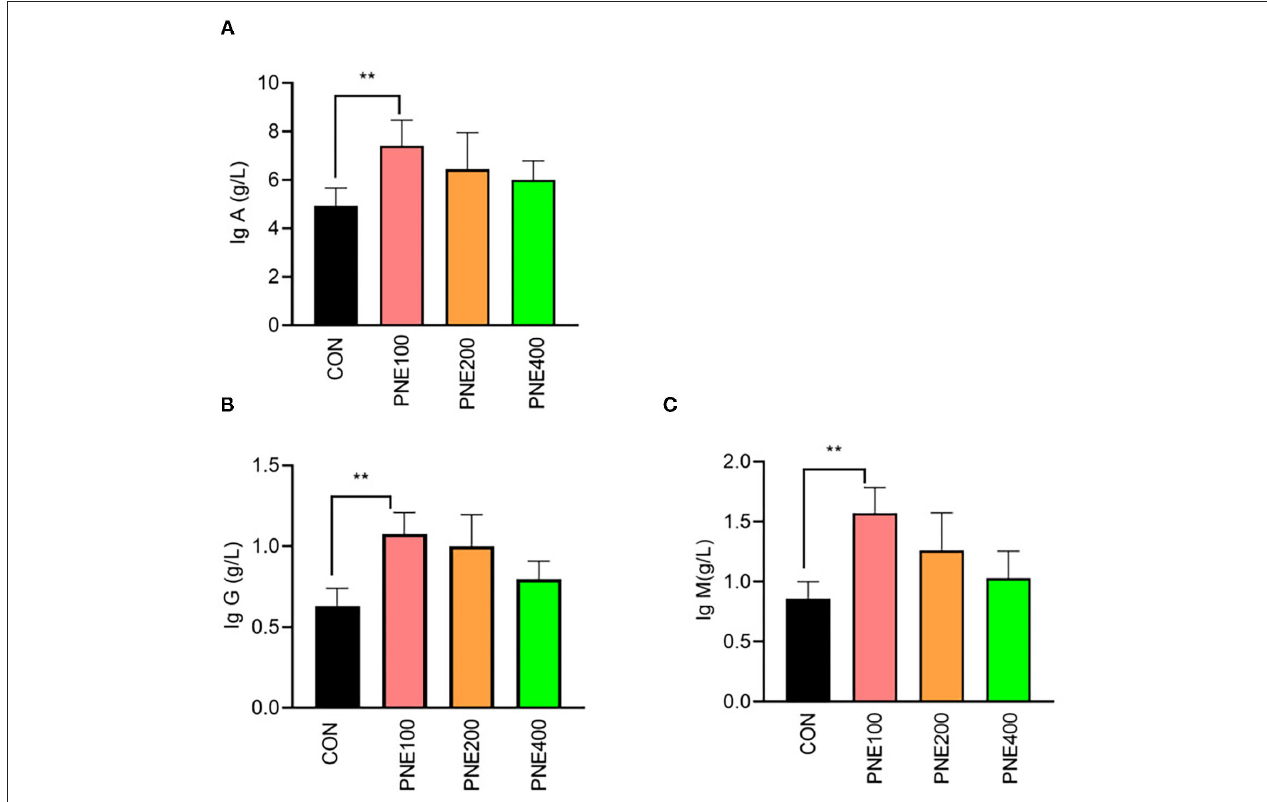
FIGURE 5 | Effect of pine needle extract (PNE) supplementation on serum immune parameters IgA (A) , IgG (B) , and IgM (C) of laying hens. IgA, immunoglobulin A; IgG, immunoglobulin G; IgM, immunoglobulin M. Asterisks denote significant differences (** p ≤ 0.01), n = 6 per group, data are expressed as means ±